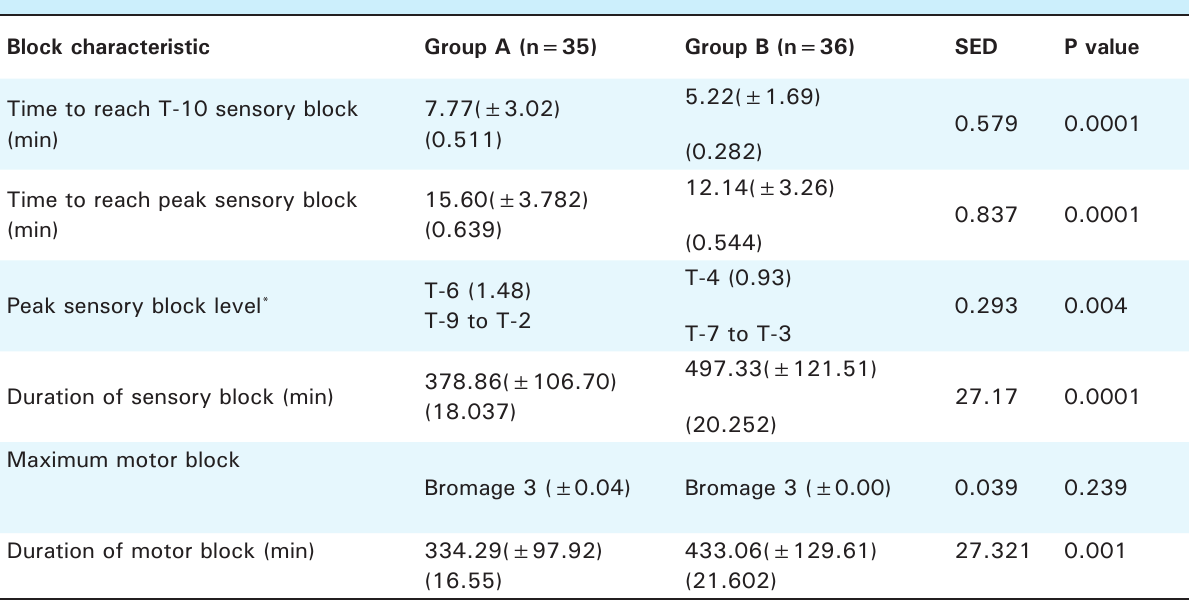
Table 2. Characteristics of sensory and motor block.